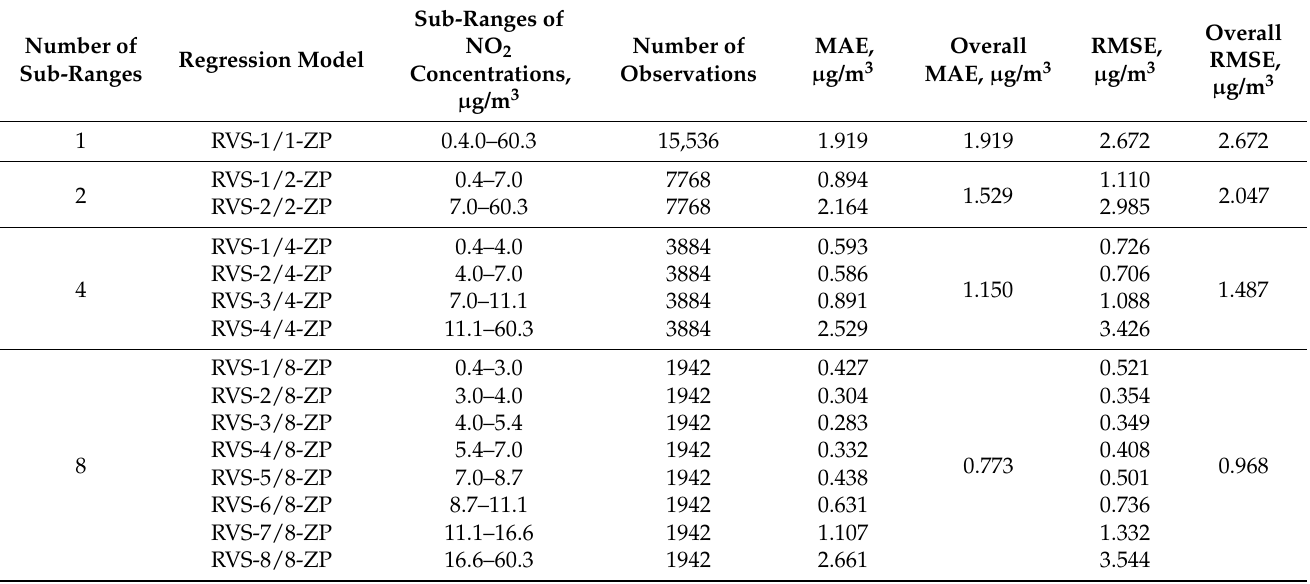
Table 14. Values of approximation errors of NO 2 concentrations in RVS models, Złoty Potok 2011–